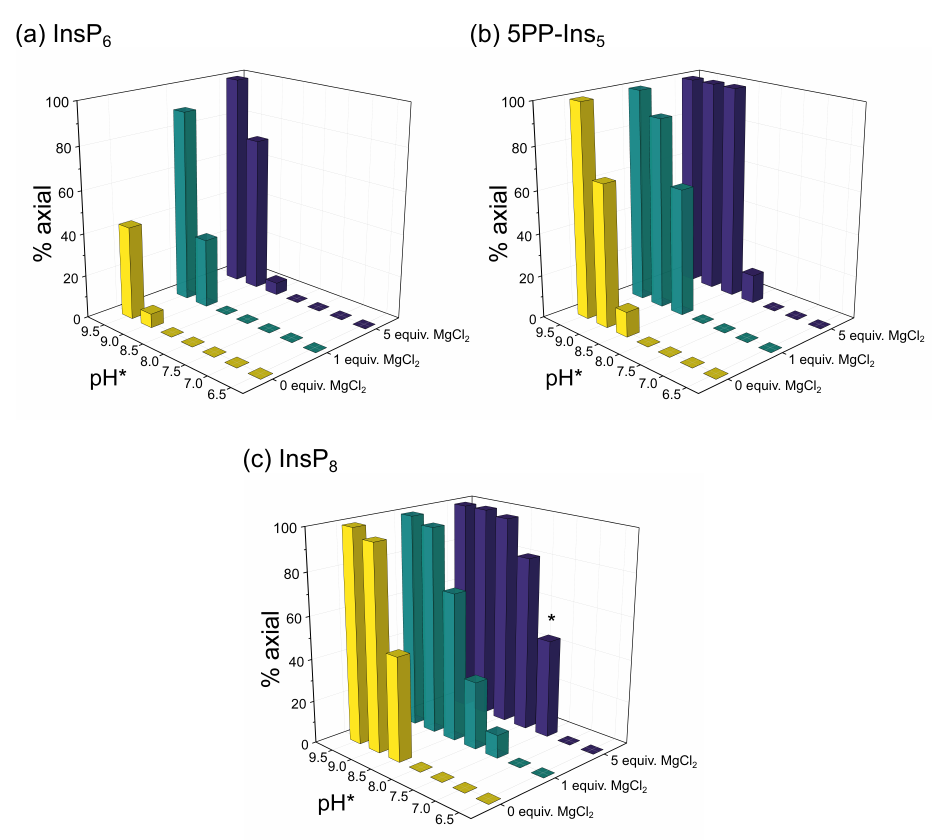
Figure 3. Relative abundance of ( a ) InsP 6 , ( b ) 5PP-InsP 5 and ( c ) InsP 8 in axial conformation at different pH and 50 µ M total InsP concentration in the presence of 0/1/5 equivalents MgCl 2 and physiological background of 130 mM KCl and 10 mM NaCl. 1 H, 13 C-HMQC-NMR spectra were measured at 4 ◦ C and integrated to obtain the ratio of eq. to ax. conformation. The proportion of ax. InsPs increases with pH, Mg 2+ concentration and phosphorylation state (InsP 6 < 5PP-InsP 5 < InsP 8 ). Intriguingly, about half of InsP 8 molecules are in ax. conformation at physiological pH in the presence of five equivalents MgCl 2 (bar marked with *). To enable NMR detection, all samples were made up in D 2 O. pH*-values measured in D 2 O can be converted to pH using the following formula: pH = 0.929 × pH* + 0.42 [35]. Peaks of both conformations were integrated to obtain the relative abundance of axial vs. equatorial